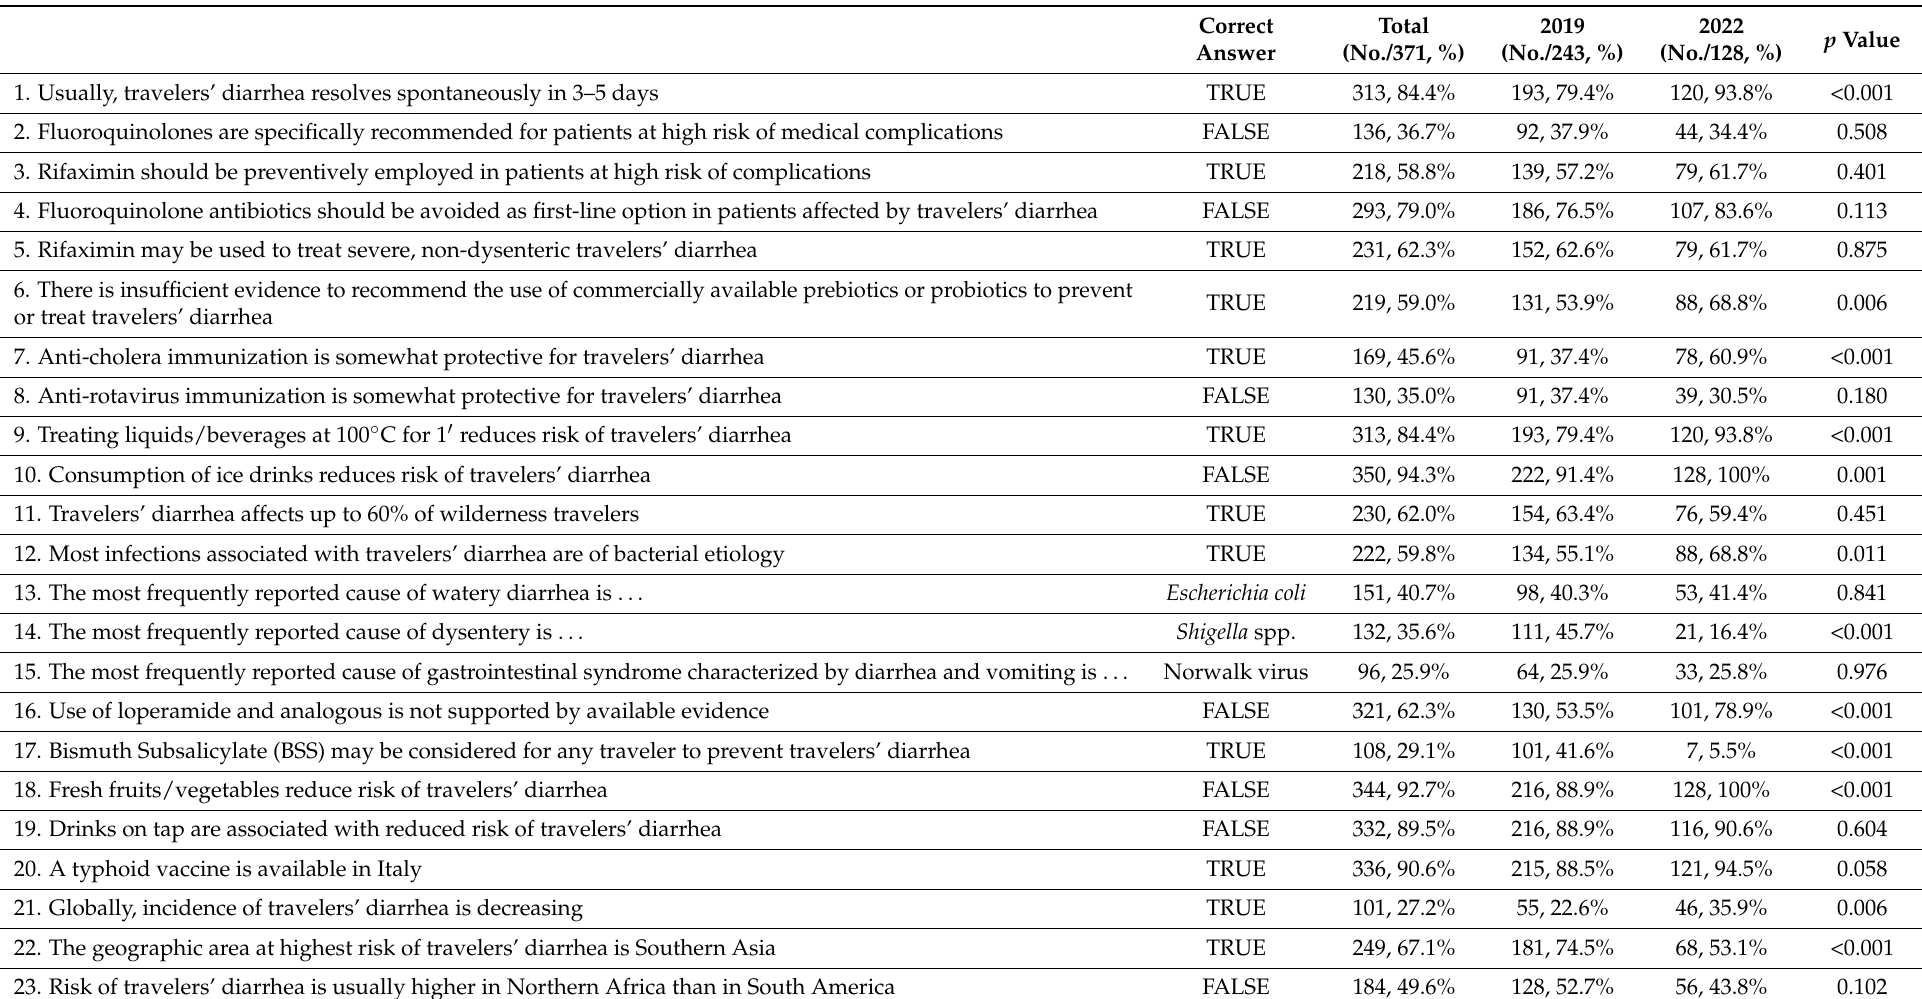
Table 2. Items included in the knowledge test and corresponding correct answers from 371 physicians from northwestern Italy (internal consistency assessed through determination of Cronbach’s Alpha, value 0.707). Comparisons between 2019 and 2022 were performed by means of chi-squared